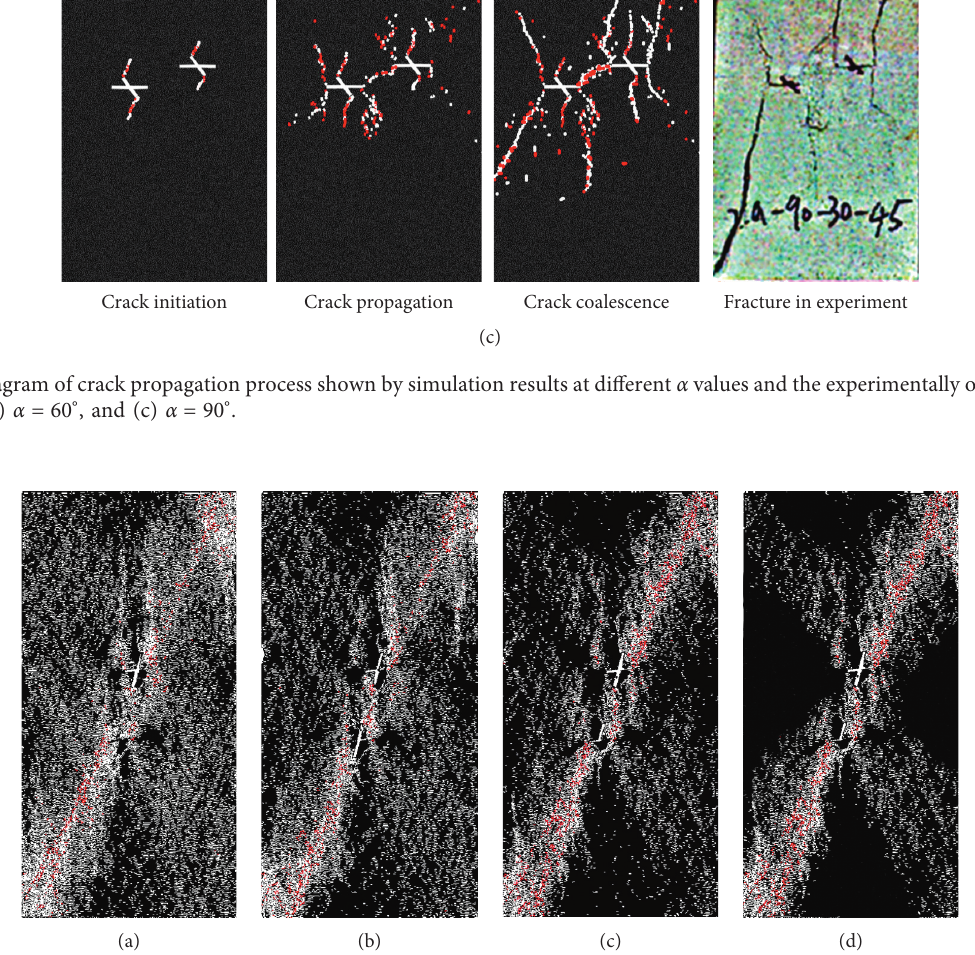
Figure 16: Crack distribution in rocks for different ratios of uniaxial compressive strength to tensile strength: (a) UCS/TS � 13.93, (b) UCS/ TS � 11.72, (c) UCS/TS � 9.79, and (d) UCS/TS � 7.82. Table 8: Total number of cracks and the numbers of tensile and shear cracks for different ratios of uniaxial compressive strength to tensile strength.